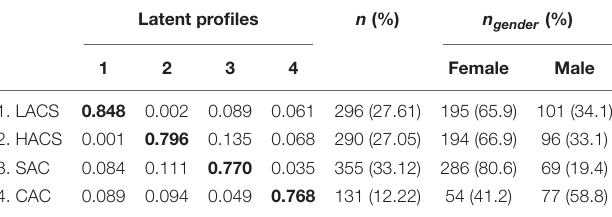
TABLE 3 | Characterization of the latent profiles and classifying accuracy of the individuals in each profile.